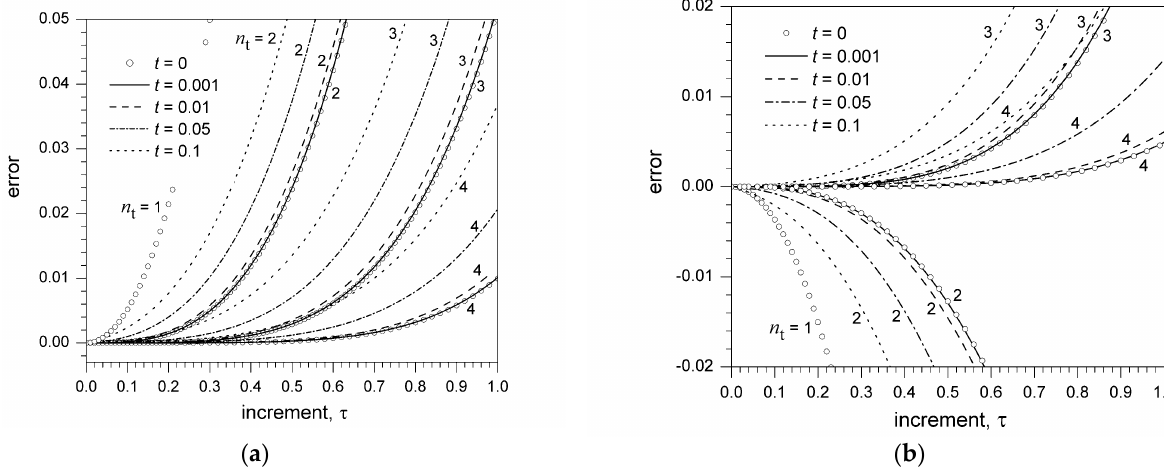
Figure 1. ( a ) Dependence on the increment τ of the error ε U, n related to the truncation of the U-expansion of e t 0 + τ (Equation (17)) for t 0 = 0, different values of t ( t = 0.001, 0.01, 0.05, 0.1 ) , and different orders of truncation n t ( n t = 2, 3, 4 ) . The error ε T, n related to the truncation ( n t = 1, 2, 3,4 ) of the corresponding Taylor series (Equation (15)) is also reported for comparison. ( b ) Dependence on the increment τ of the error ε U, n related to the truncation of the U-expansion of sin ( t 0 + τ ) (Equation (18)) for t 0 = π /4, different values of t ( t = 0.001, 0.01, 0.05, 0.1 ) , and different orders of truncation n t ( n t = 2, 3, 4 ) . The error ε T, n related to the truncation ( n t = 1, 2, 3,4 ) of the corresponding Taylor series (Equation (16)) is also reported for comparison. The error is defined as the difference between the exact value of the function and the value of the truncated series expansion.